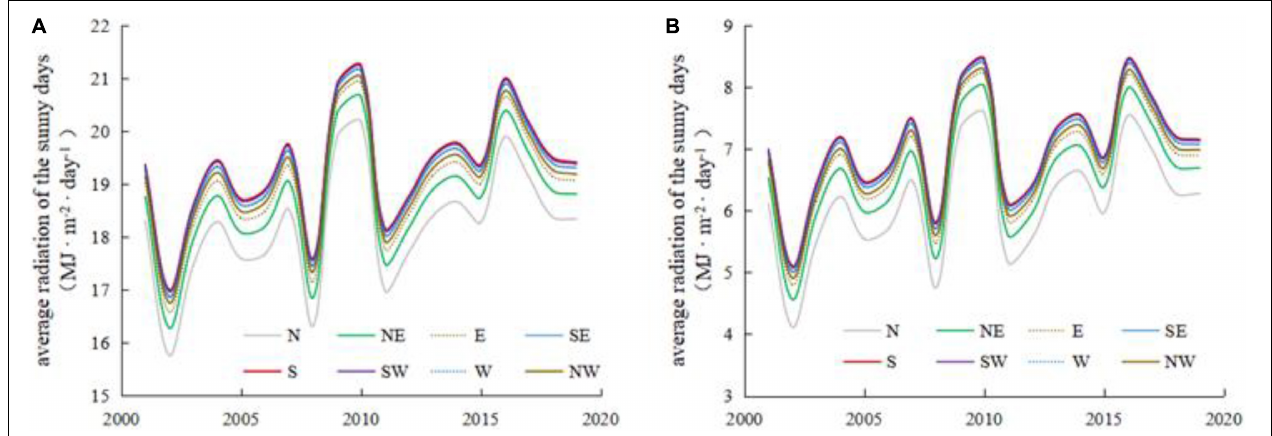
FIGURE 10 | Average daily solar radiation under clear-sky conditions on different slopes from 2001 ∼ 2019 in the Haihe River Basin. (A) Solar incident radiation; (B) Surface net